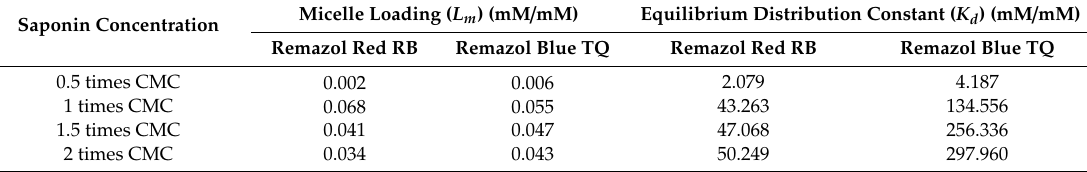
Table 3. E ff ect of saponin concentration on the equilibrium distribution constant and micelle loading for Remazol Red and